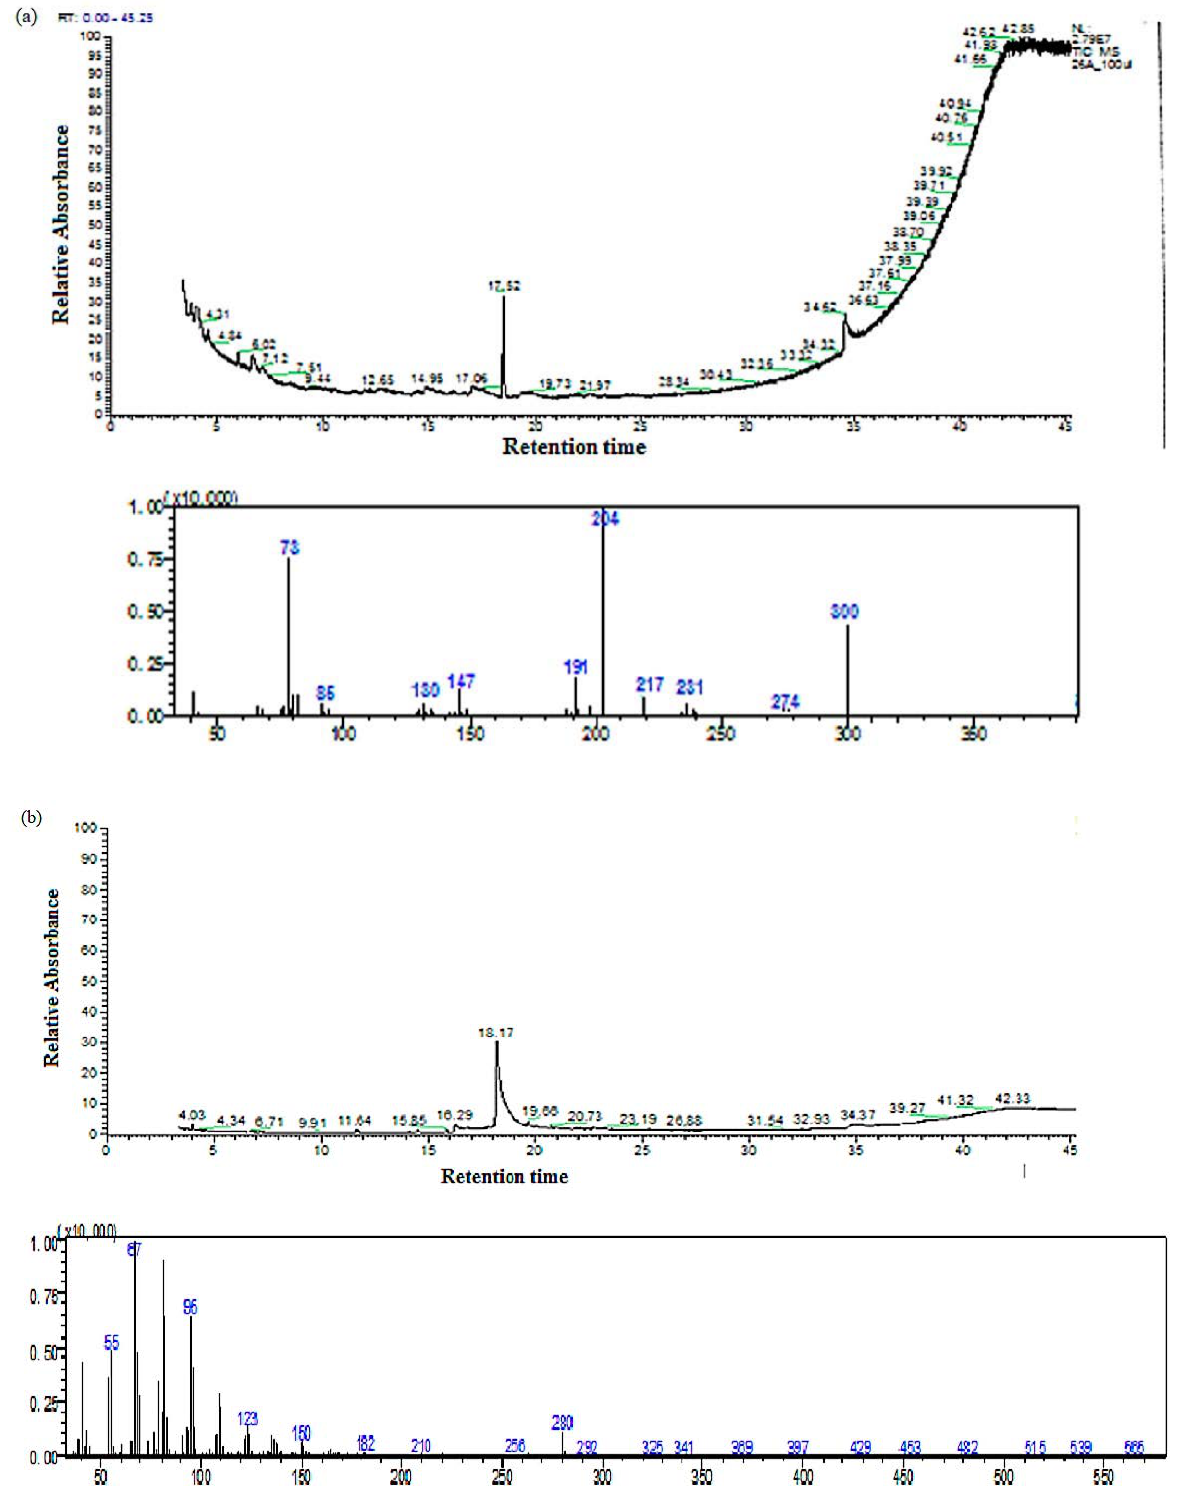
Figure 7. Mass spectra of ( a ) Compound 1 (Dehydroabietic acid) and ( b ) Compound 2 (Linoleic acid).